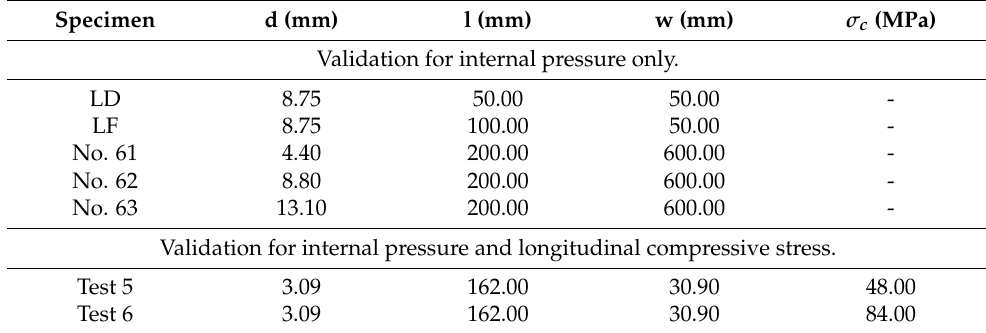
Table 6. Dimension of corrosion defects and applied longitudinal compressive stress of selected specimens for FEM